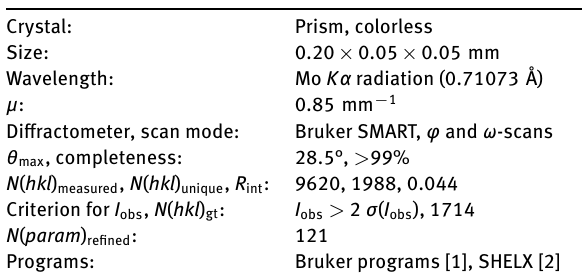
Table 1: Data collection and handling.